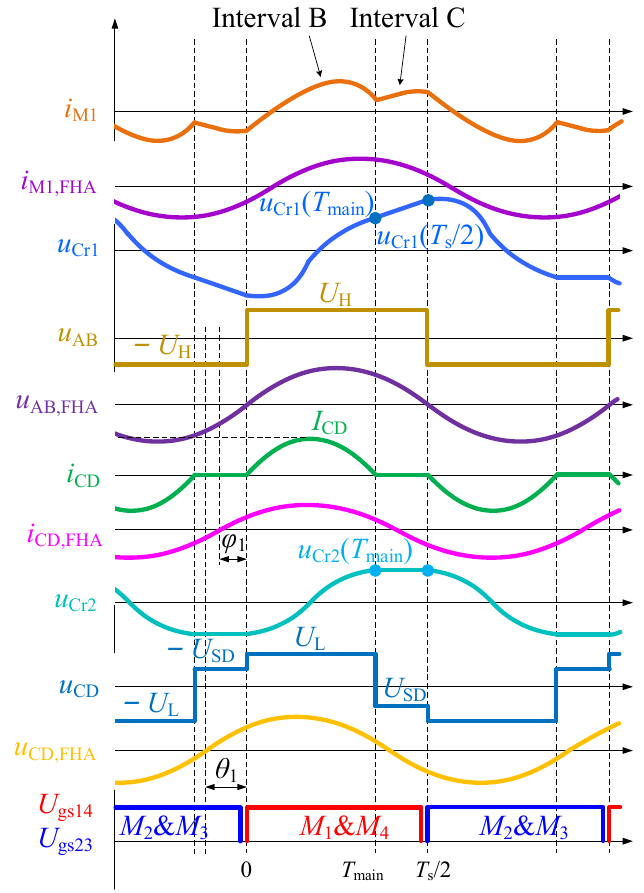
Figure 10. Waveforms in step-down mode.